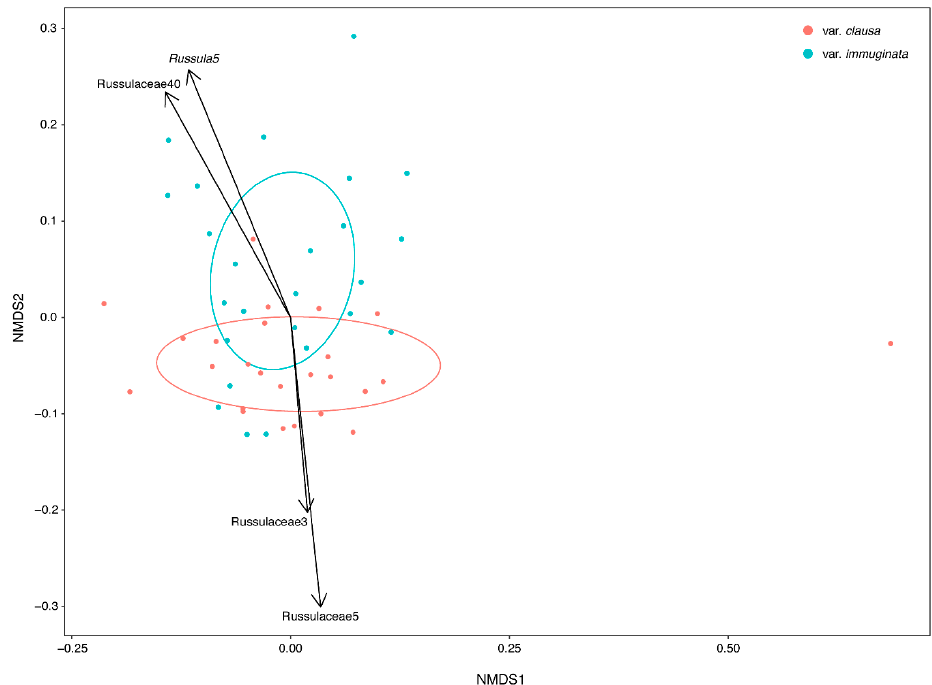
Figure 3. Nonmetric multidimensional scaling ordinations for fungal communities as a function of host variety. Points represent communities recovered from individual trees of Pinus clausa var. clausa (salmon) and Pinus clausa var. immuginata (blue). Ellipses indicate 95% confidence intervals, while arrows specify significant indicator species associated with each variety.